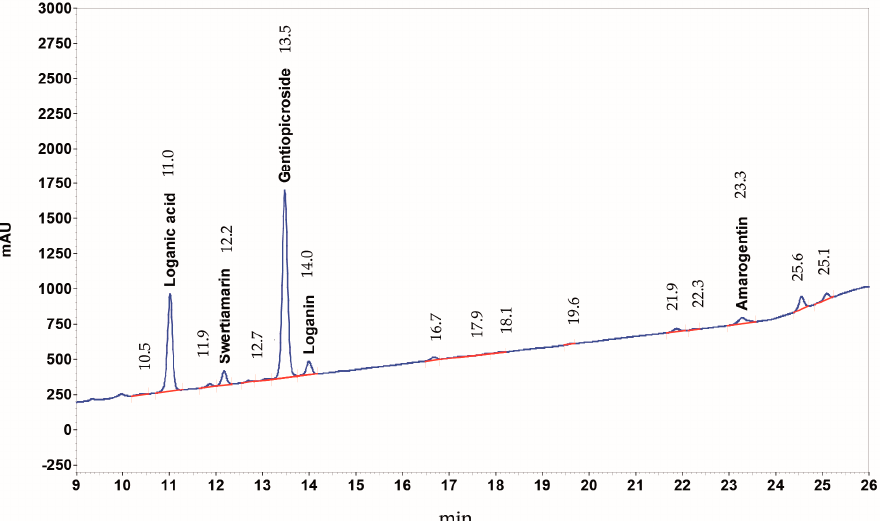
Figure 7. HPLC-UV chromatogram of yellow gentian root CO 2 -extract. The detection was at 232 nm: peak identifications (concentrations) are: loganic acid (3.1%), swertiamarin (0.79%), gentiopicroside (12.3%), loganin (0.41%), and amarogentin (0.05%).